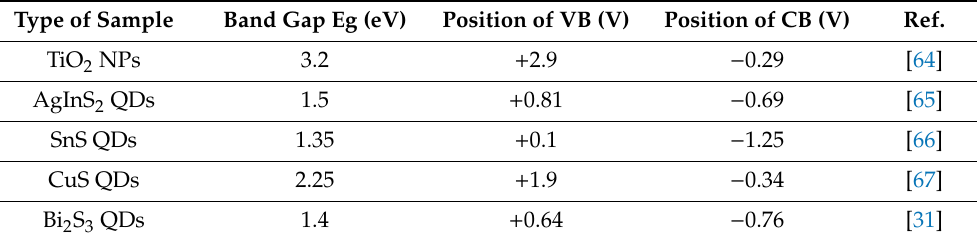
Table 2. Band gap values and positions of the VB and CB for tested